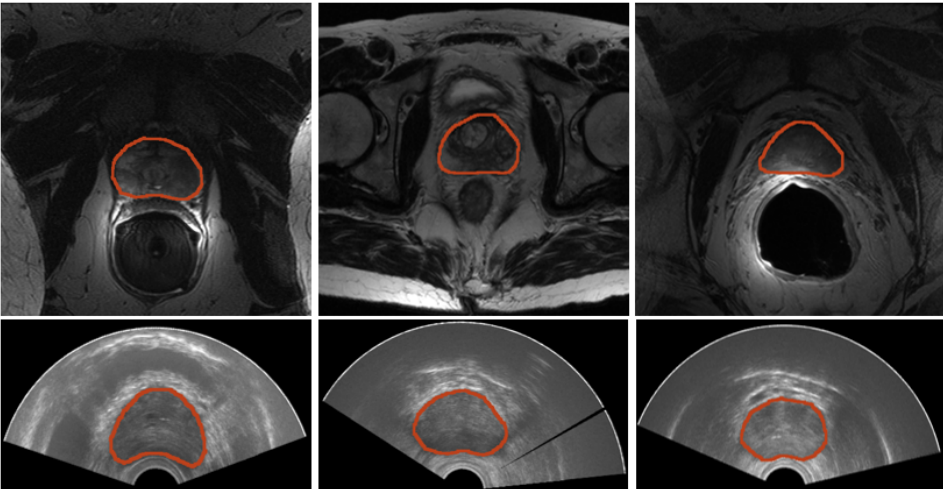
Figure 2. Samples of images from both modalities. ( Top ) Prostate MRI. From left to right, a sample image for each of the datasets—PROMISE12, SAML, and ZENODO—is shown. ( Bottom ) Three sample prostate TRUS from the ZENODO